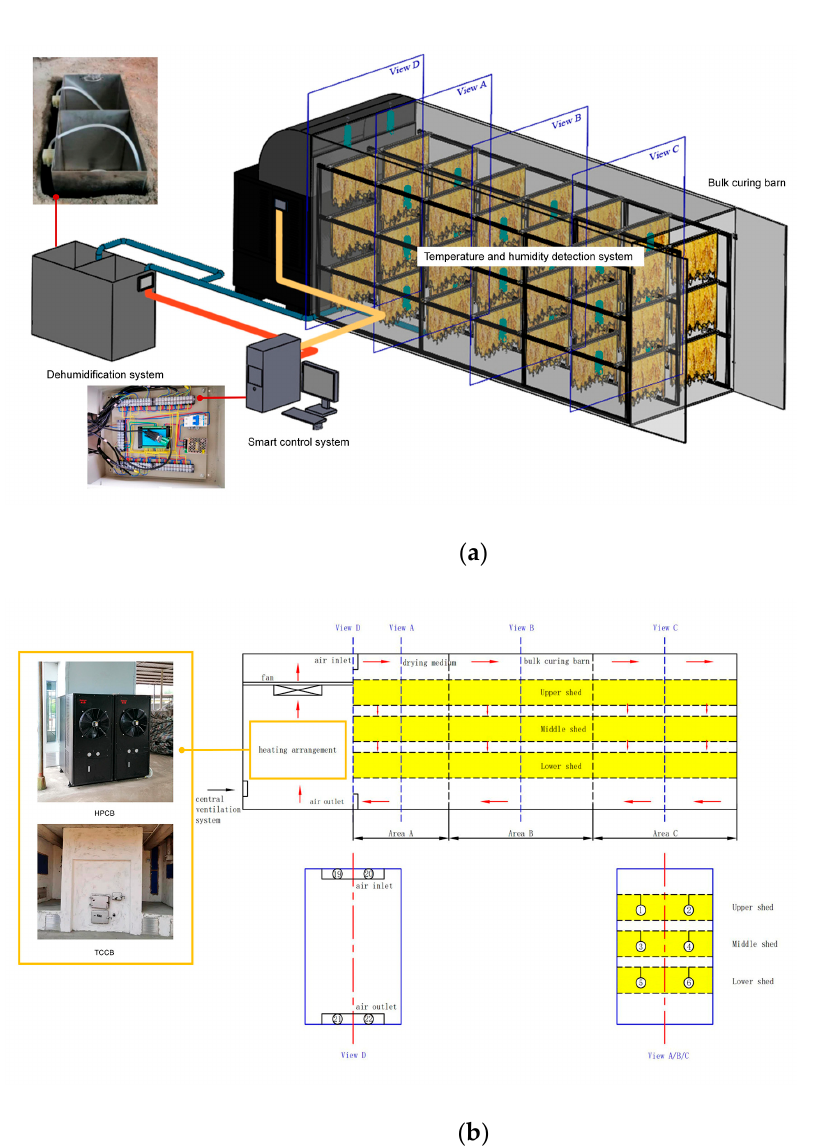
Figure 1. The experimental equipment: ( a ) structure and ( b ) schematic diagram of the bulk curing barn. Table 1. The main parameters of the